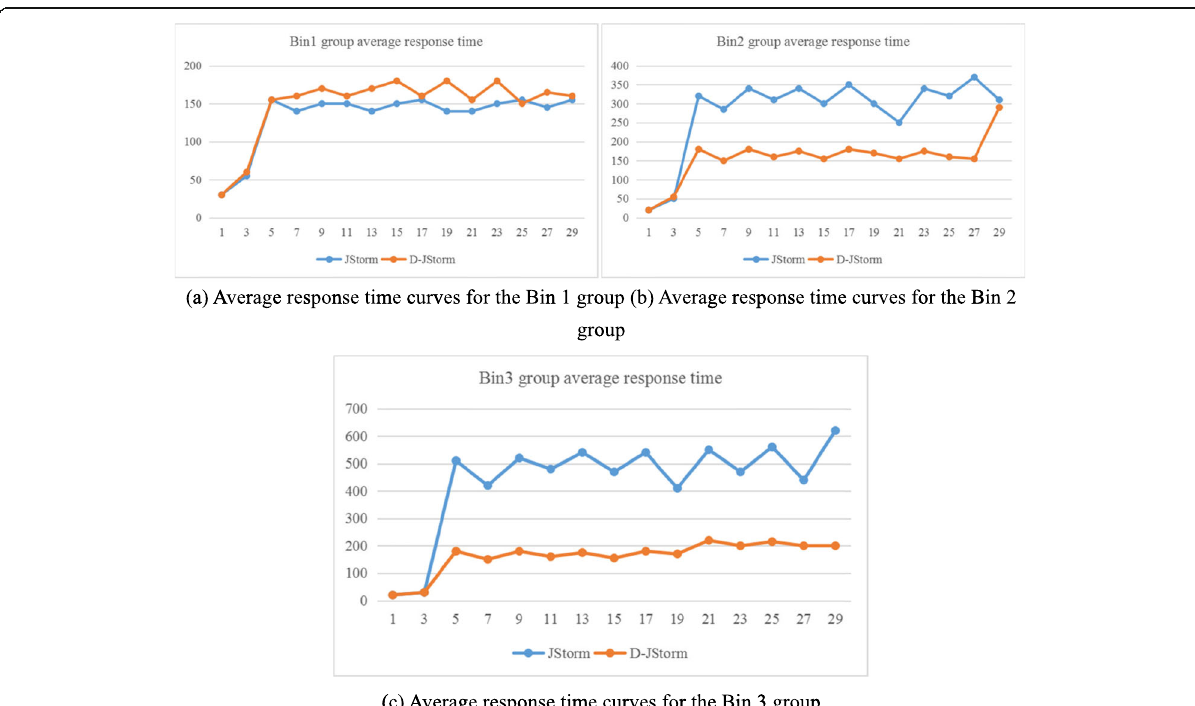
Fig. 4 Average response time curve in different initial configurations. a Average response time curves for the Bin 1 group. b Average response time curves for the Bin 2 group. c Average response time curves for the Bin 3